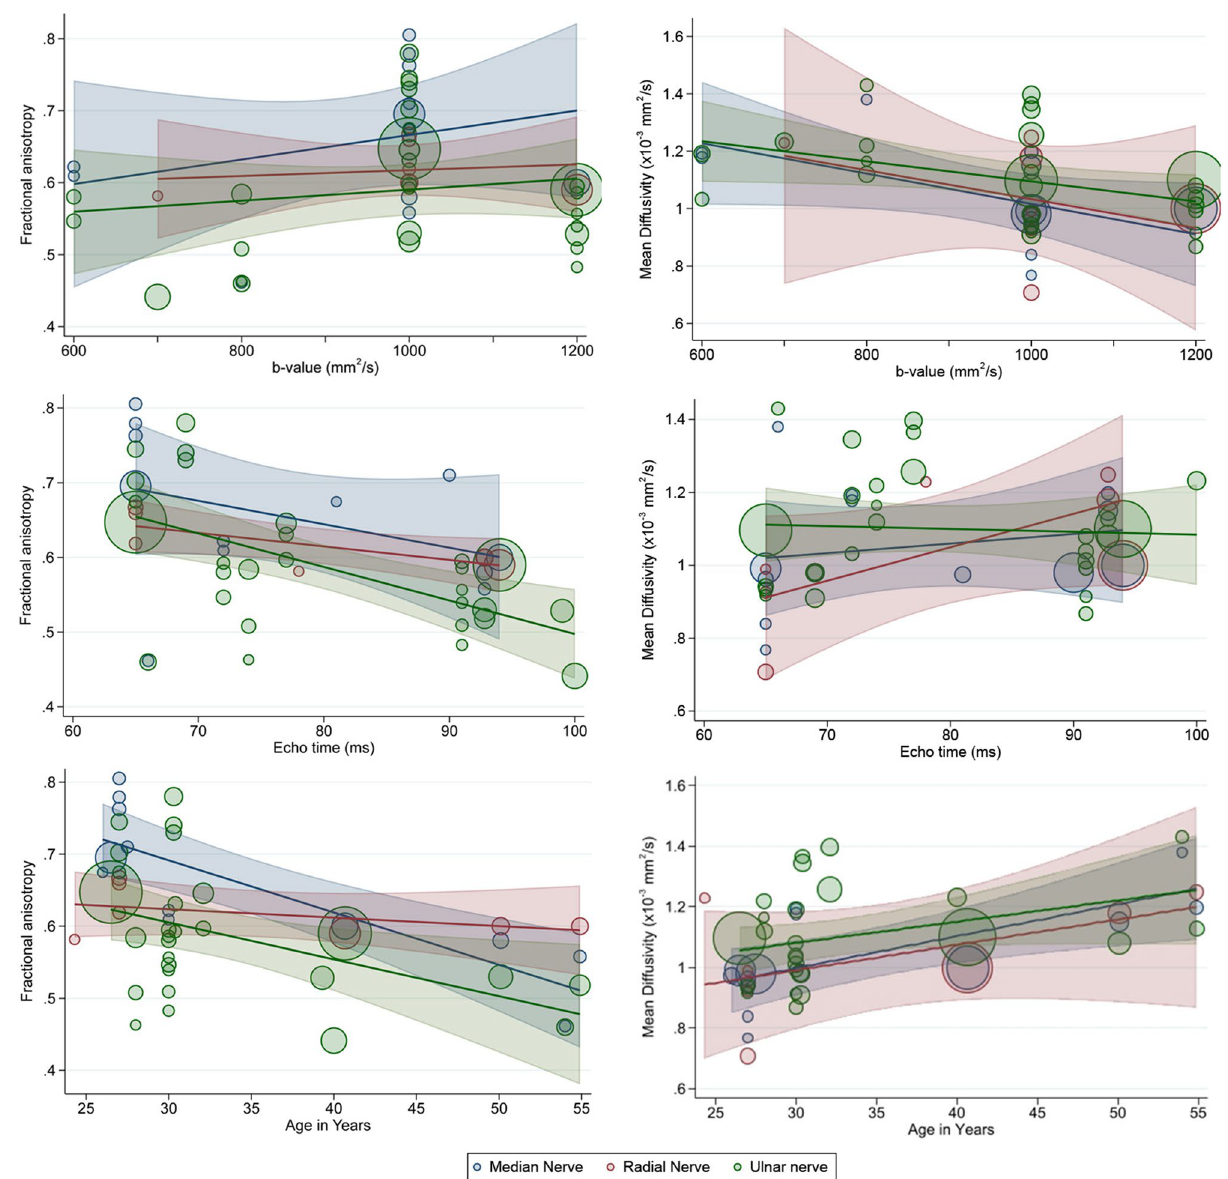
Figure 4. Bubble plots showing the linear dependence of FA (left column) and MD (right column) on the maximum b-value, echo time and aggregate mean age of participants. The size of the points corresponds to the precision (inverse variance) of the